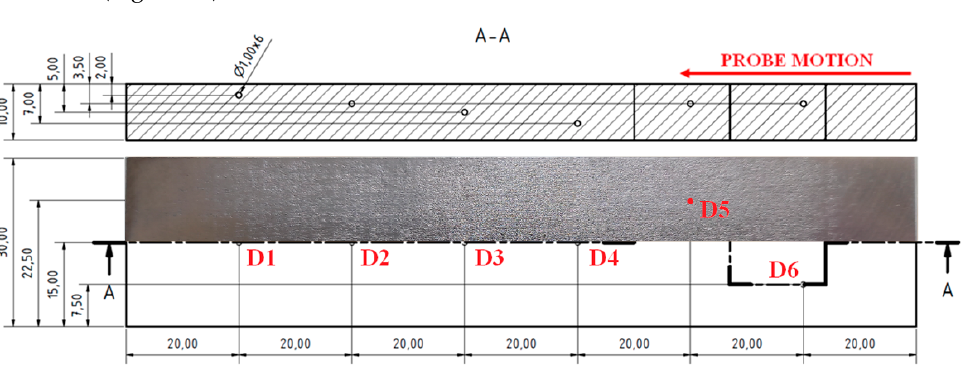
Figure 19. S6 sample.